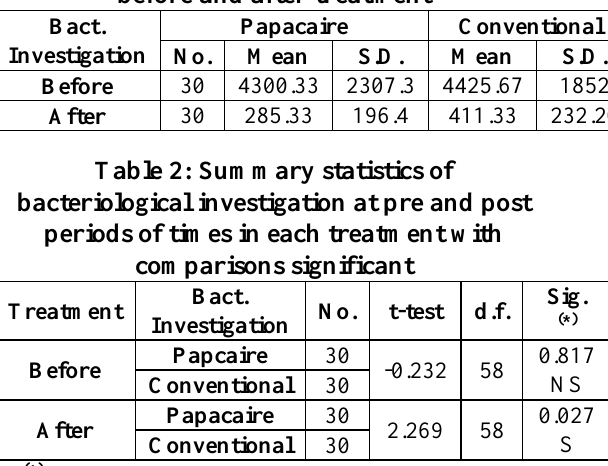
Table 1: Descriptive statistic to the bacterial